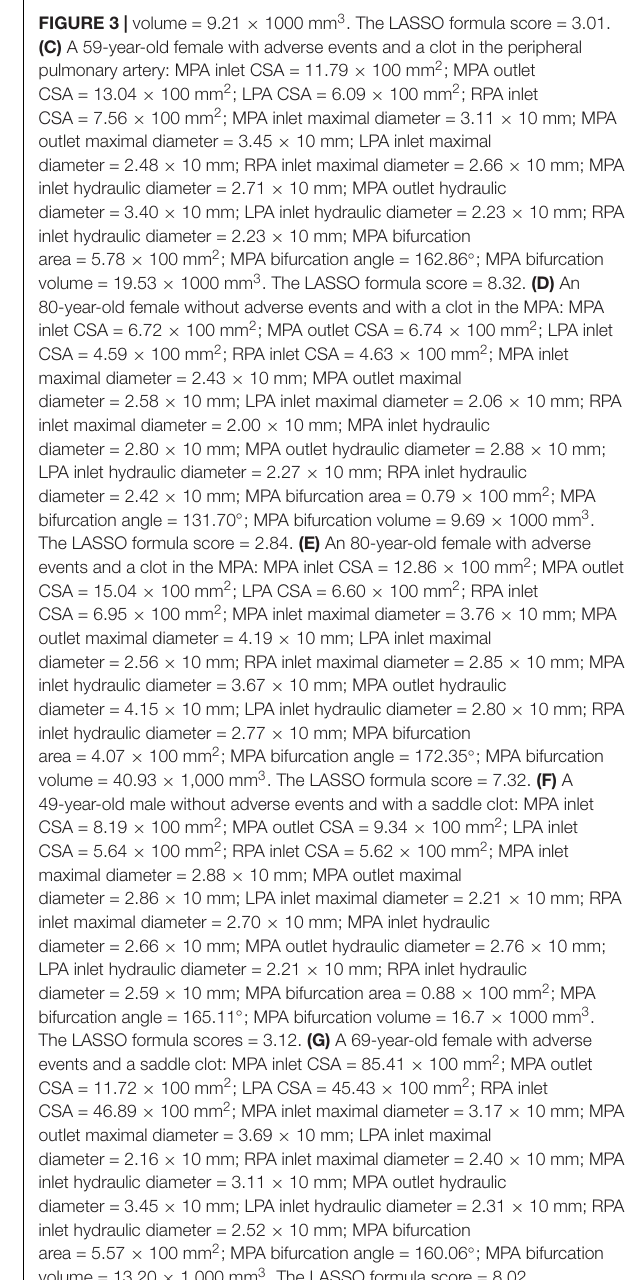
FIGURE 3 | Two examples of MPA parameter measurements. (A) The area, perimeter and maximal diameter were measured at the MPA inlet plane, MPA outlet plane, RPA inlet plane and LPA inlet plane. The hydraulic diameter was calculated as the ratio of area to the perimeter of the corresponding plane. (B) A 48-year-old female without adverse events and with a clot in the peripheral pulmonary artery: MPA inlet CSA = 6.37 × 100 mm 2 ; MPA outlet CSA = 7.68 × 100 mm 2 ; LPA inlet CSA = 3.52 × 100 mm 2 ; RPA inlet CSA = 3.31 × 100 mm 2 ; MPA inlet maximal diameter = 1.97 × 10 mm; MPA outlet maximal diameter = 2.04 × 10 mm; LPA inlet maximal diameter = 3.01 × 10 mm; RPA inlet maximal diameter = 1.62 × 10 mm; MPA inlet hydraulic diameter = 2.86 × 10 mm; MPA outlet hydraulic diameter = 2.94 × 10 mm; LPA inlet hydraulic diameter = 2.04 × 10 mm; RPA inlet hydraulic diameter = 1.97 × 10 mm; MPA bifurcation area = 0.84 × 100 mm 2 ; MPA bifurcation angle = 168.35 ◦ ; MPA bifurcation